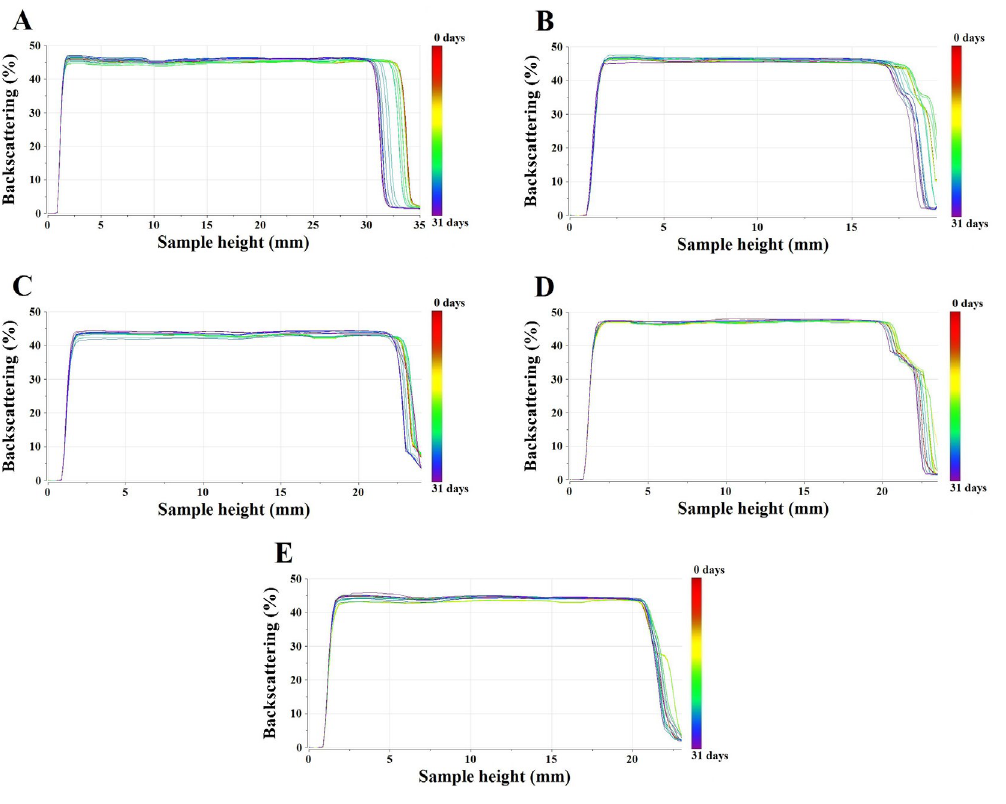
Figure 11. Backscattering profiles of E+[TiO 2 +SSQ1] ( A ), E+[TiO 2 +SSQ2] ( B ), E+[TiO 2 +SSQ3] ( C ), E+[TiO 2 +SSQ4] ( D ), E+[TiO 2 ] ( E ).